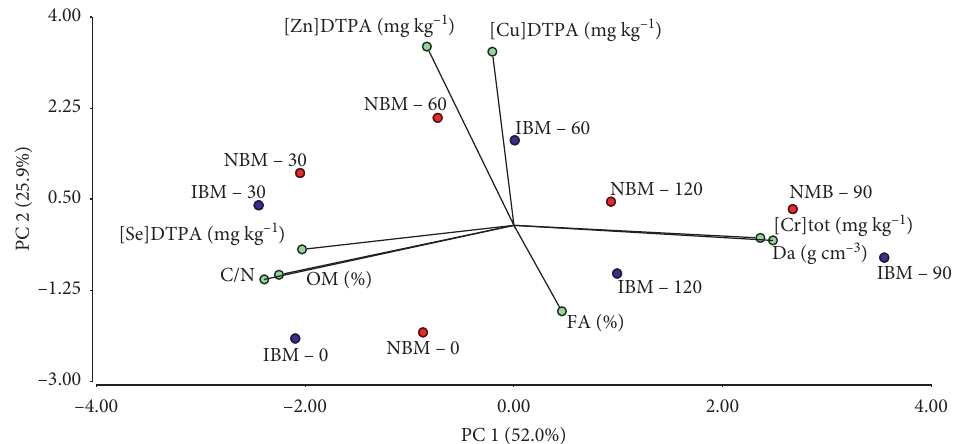
Figure 11: Unrestricted sorting analysis (with examination of principal